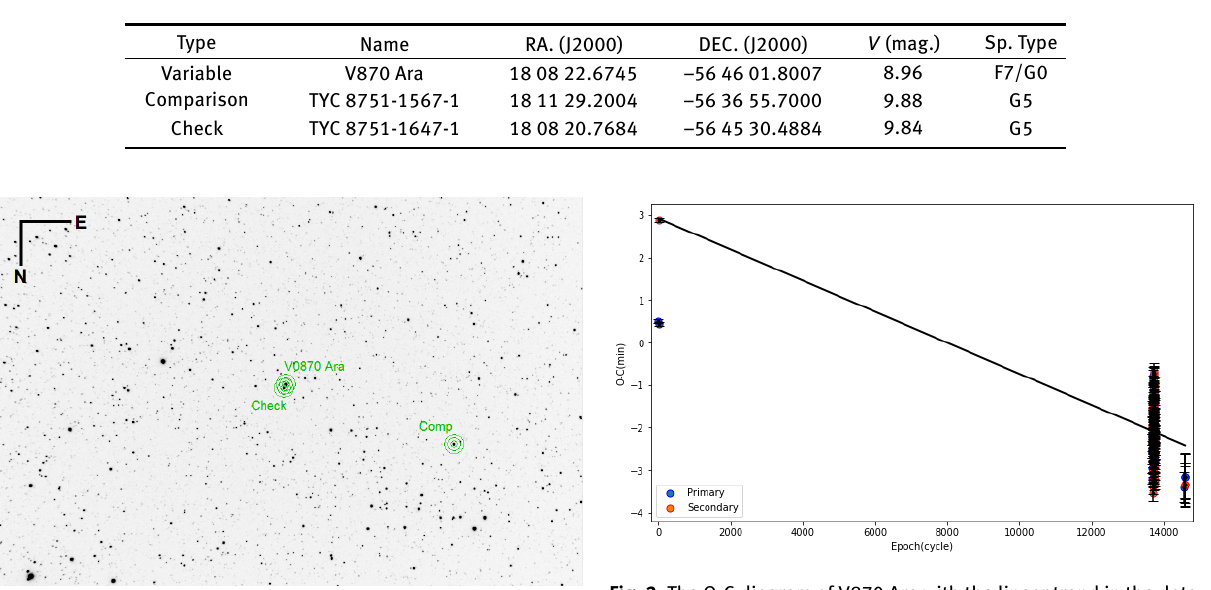
Fig. 2. The O-C diagram of V870 Ara with the linear trend in the data using the MCMC method. The blue color corresponds to primary minima times, while the red color corresponds to secondary minima